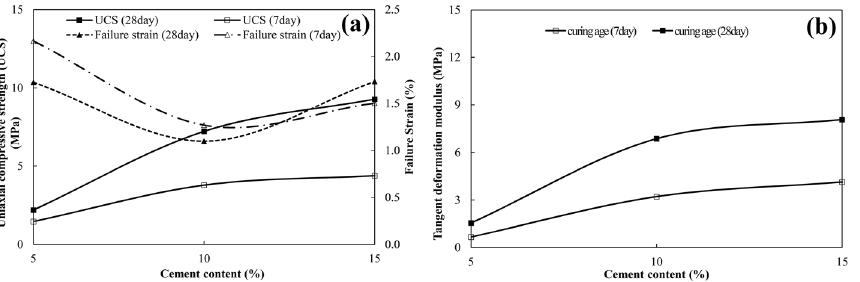
Fig. 8 The curves of ultimate stress and ultimate strain versus cement content for CSG mixtures (without fine additives) cured at the ages of 7 and 28 days